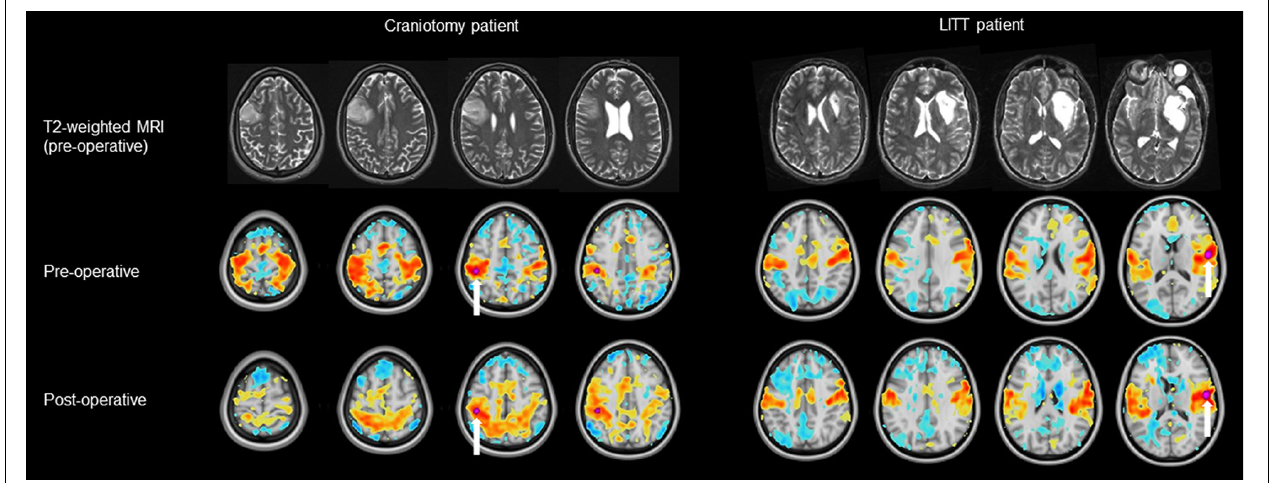
FIGURE 3 | Examples of a pre-operative and post-operative RSN (resting-state network) using a tumor-adjacent seed ROI (region of interest, labeled with a white arrow) on the contralesional hemisphere. The LITT (laser interstitial thermal therapy) patient (right) had a greater degree of correlation between the pre-operative and post-operative RSN than did the craniotomy patient (left). Note: clinical images use anatomic orientation while RSN projections use neurologic orientation.